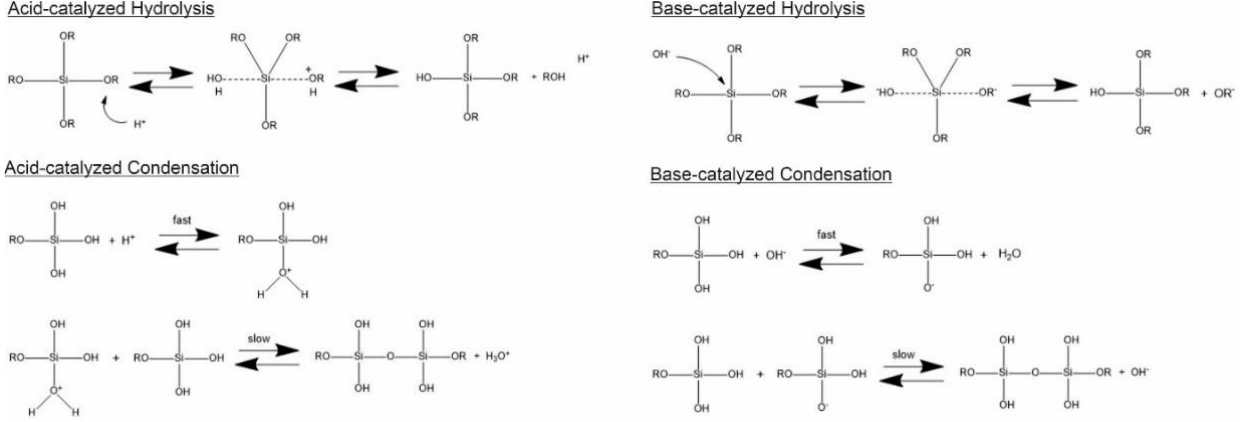
Scheme 1. Hydrolysis and condensation in acidic and basic conditions. Adapted from [26]. Copy- right © 2022, American Chemical Society.